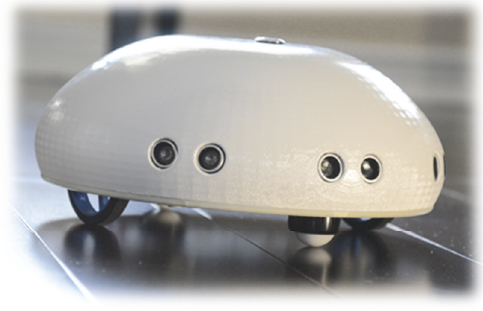
Figure 7: Nonholonomic